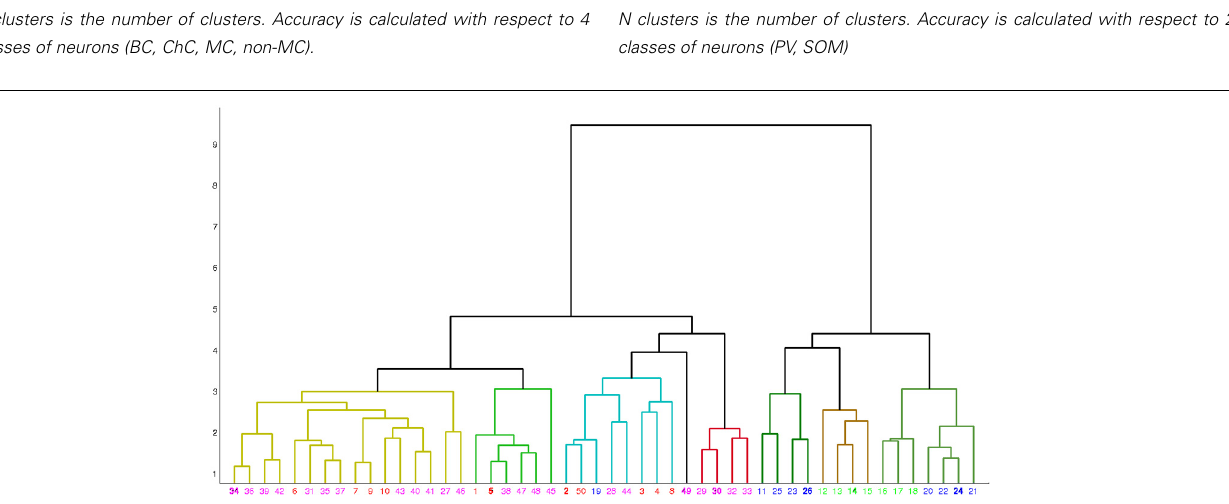
FIGURE 4 | Hierarchical clustering found by Ward’s method for the morphology and physiology database. Neurons are represented by their index in the database. Colors red, blue, green, and magenta,